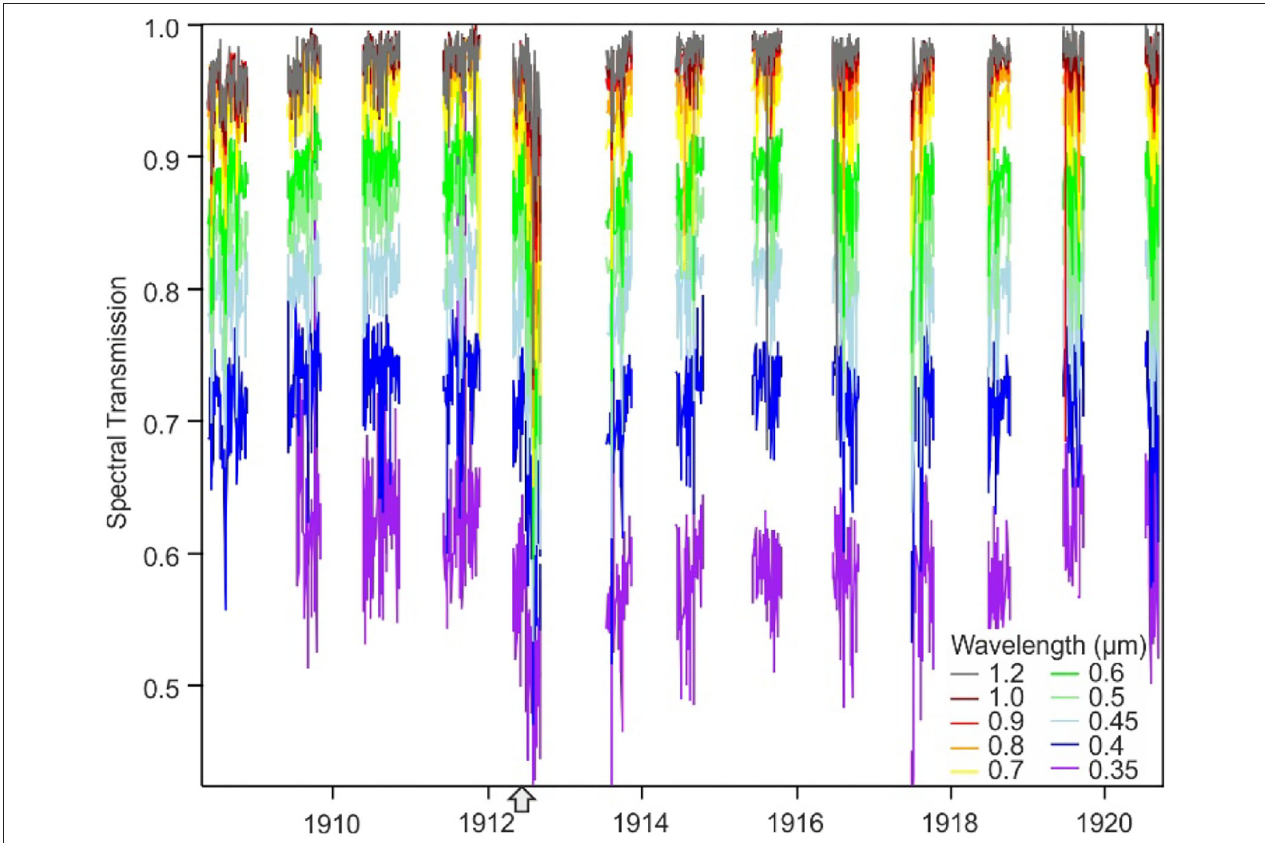
FIGURE 8 | Daily spectral transmission at Mount Wilson from the observations of the Smithsonian institution (Stickler et al., 2010). The arrow marks the eruption of Novarupta in